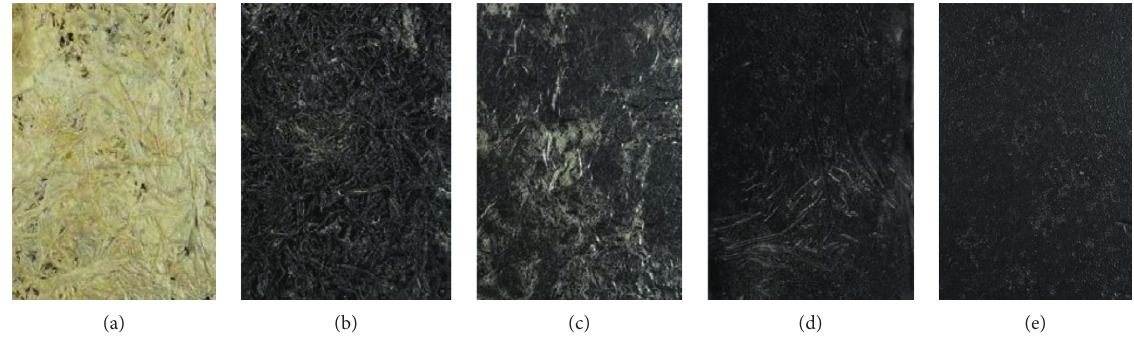
Figure 4: Developed composite plates. (a) BBC-A; (b) BBC-B; (c) BBC-C; (d) BBC-D; (e) BBC-E.